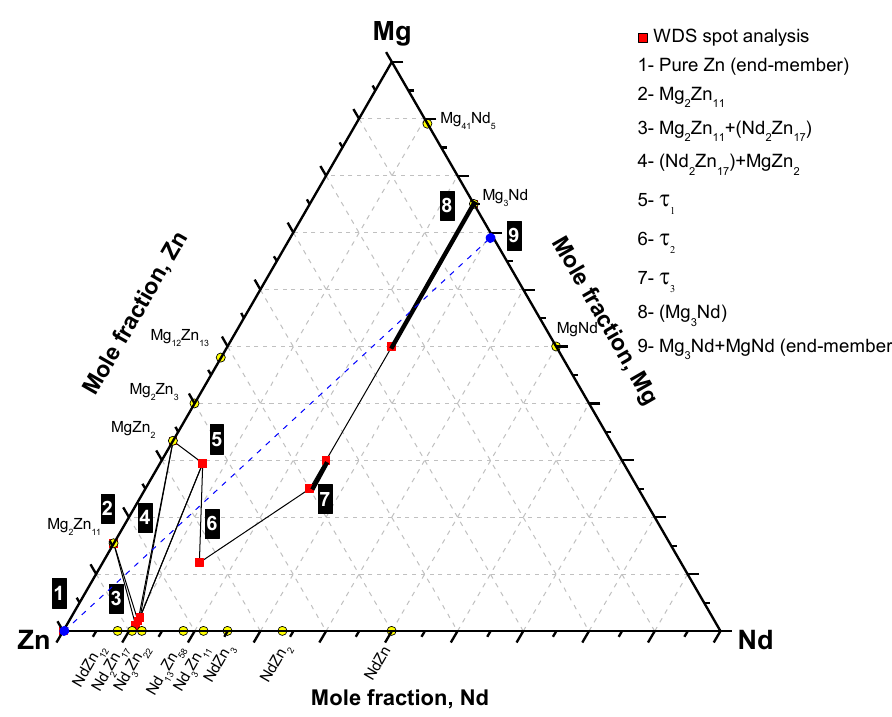
Figure 4. The phase equilibria depicted from diffusion couple